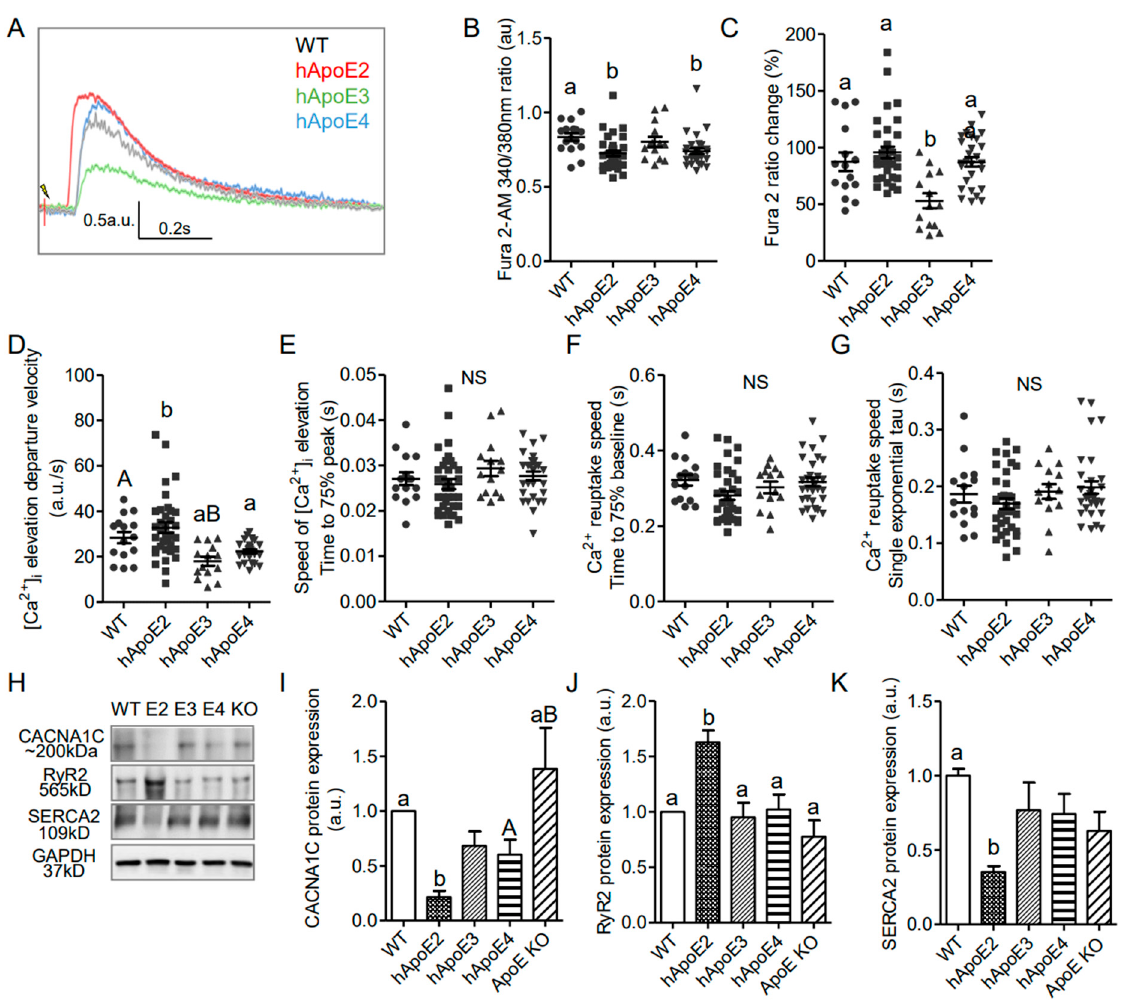
Figure 5. Intracellular Ca 2+ transients indicated that Ca 2+ increased more and more quickly after stimulation in isolated adult hApoE2 cardiomyocytes. ( A ) Representative traces of intracellular Ca 2+ transients are shown. Fura2-AM signal was used as an index of intracellular Ca 2+ concentration. ( B ) The basal concentration of intracellular Ca 2+ indicated by the Fura2-AM signal was compared in isolated relaxed adult cardiomyocytes. ( C ) Percent change of Fura2-AM signal was compared in rat cardiomyocytes after electric stimulation of 5 to 8 volts at 1 Hz. ( D ) The departure velocity, indicating the maximal rate of Ca 2+ change, was compared. ( E ) The time to 75% of maximal departure velocity, indicating how fast the signal increased, was compared. ( F ) The time to 75% baseline, representing the time that the Ca 2+ signal dropped 75% of total change, a parameter of Ca 2+ reuptake speed, was compared during relaxation. ( G ) The single exponential tau, equaling the time taken for switching on Ca 2+ reuptake during the relaxation phase, was compared as well. A greater tau value means a longer Ca 2+ reuptake time. ( H – K ) Western blotting was applied to detect the proteins responsible for intracellular Ca 2+ signal, using antibodies specific to L-type Ca 2+ channels (anti-CACNA1C), ryanodine receptors (anti-RyR2), and sarcoplasmic reticulum Ca 2+ ATPase (anti-ATP2A/SERCA2) in heart lysate of different rats. One-way ANOVA followed by a Tukey post hoc test. a vs. b, A vs. B, p < 0.05, NS, no significant difference. Cells indicated by symbols were from three rats per group. Six rats per group were used for Western blotting analysis.